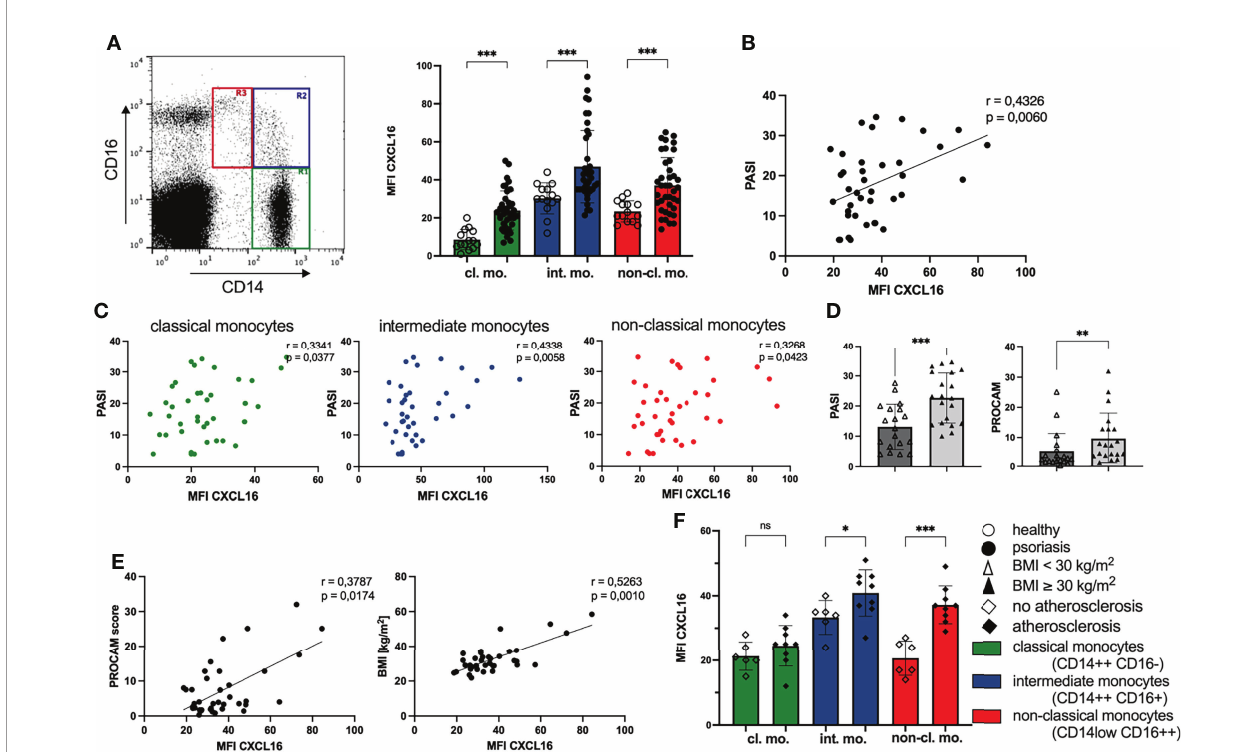
FIGURE 1 | Expression of CXCL16 on monocytes is associated with enhanced clinical disease activity and cardiovascular risk. (A) Flow cytometry analysis of CXCL16 expression on monocyte subpopulations de fi ned by gating for CD14 and CD16 expression in PBMC: classical monocytes (CD14++ CD16-, R1 green), intermediate monocytes (CD14++ CD16+, R2 blue) and non-classical monocytes (CD14low CD16++, R3, red), mean and SD of healthy controls (n= 14; un fi lled dots) and patients with psoriasis vulgaris (n= 39; fi lled dots), Welch ’ s t test. (B) Correlation of CXCL16 expression on all monocytes of psoriatic patients (n=39) and clinical disease activity (PASI), Pearson ’ s correlation. (C) Correlation for each monocyte subset de fi ned by color indicated in (A) and PASI score, Pearson ’ s correlation. (D) Mean and SD of PASI (unpaired t test) and PROCAM (Mann-Whitney test) of normal-weight (un fi lled triangles; n=19) and obese psoriatic patients ( fi lled triangles; n=20). (E) Correlation of chemokine expression with cardiovascular risk (PROCAM score); and body-mass-index (BMI). Each dot represents an individual patient, Pearson correlation. (F) CXCL16 expression on monocytes in psoriatic patients without atherosclerosis (n= 6; un fi lled trapezoid) or with atherosclerosis (n= 9; fi lled trapezoid), mean and SD, unpaired t test. *p < 0.05; **p < 0.01; ***< 0.001. ns, not signi fi